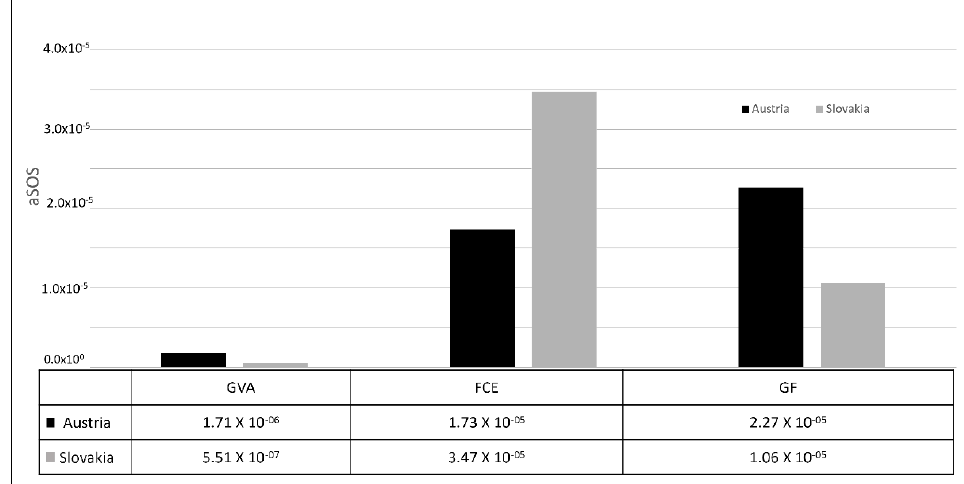
Figure 2. aSOS at an industry level using three different downscaling methods.